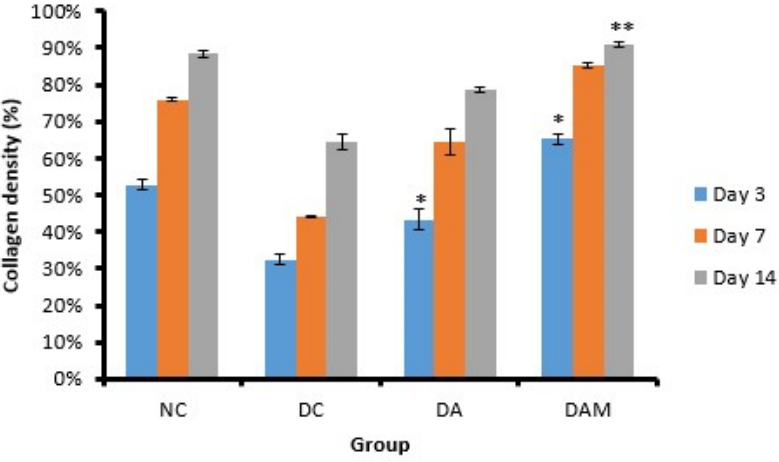
Figure 10. Collagen density was evaluated at the three variation times. Notation on the graph shows the result of the statistical test ( α < 0.05). * and ** notation shows insignificant differences with NC but significant differences with DC. * = 0.01 ≤ α < 0.05; ** = α ≤ 0.01. NC: normal group; DA: alginate treatment group; DAM: alginate–mangosteen rind extract treatment group; and DC: diabetic